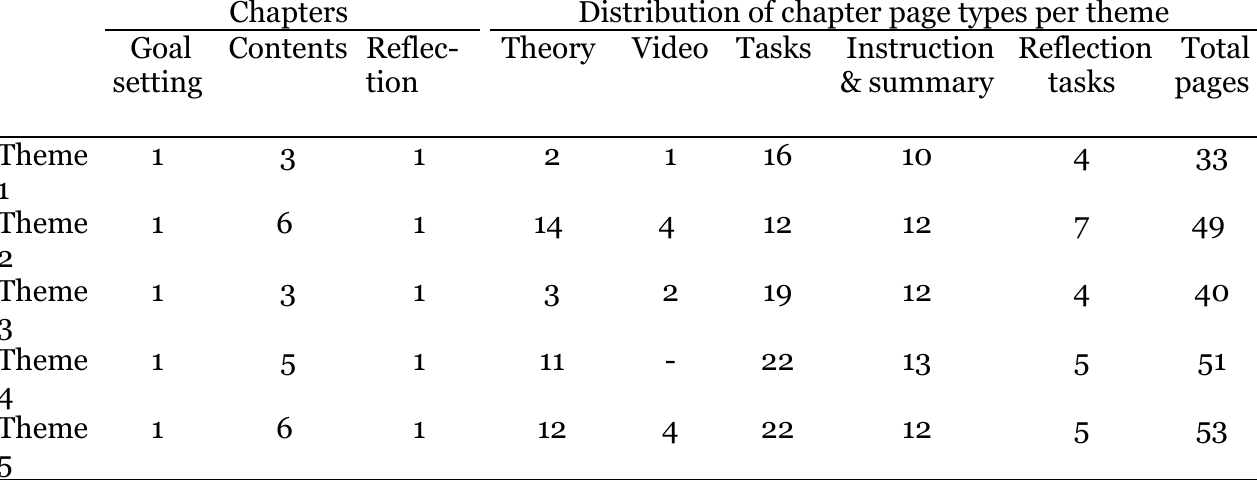
Frequencies of chapters and their contents per lesson theme